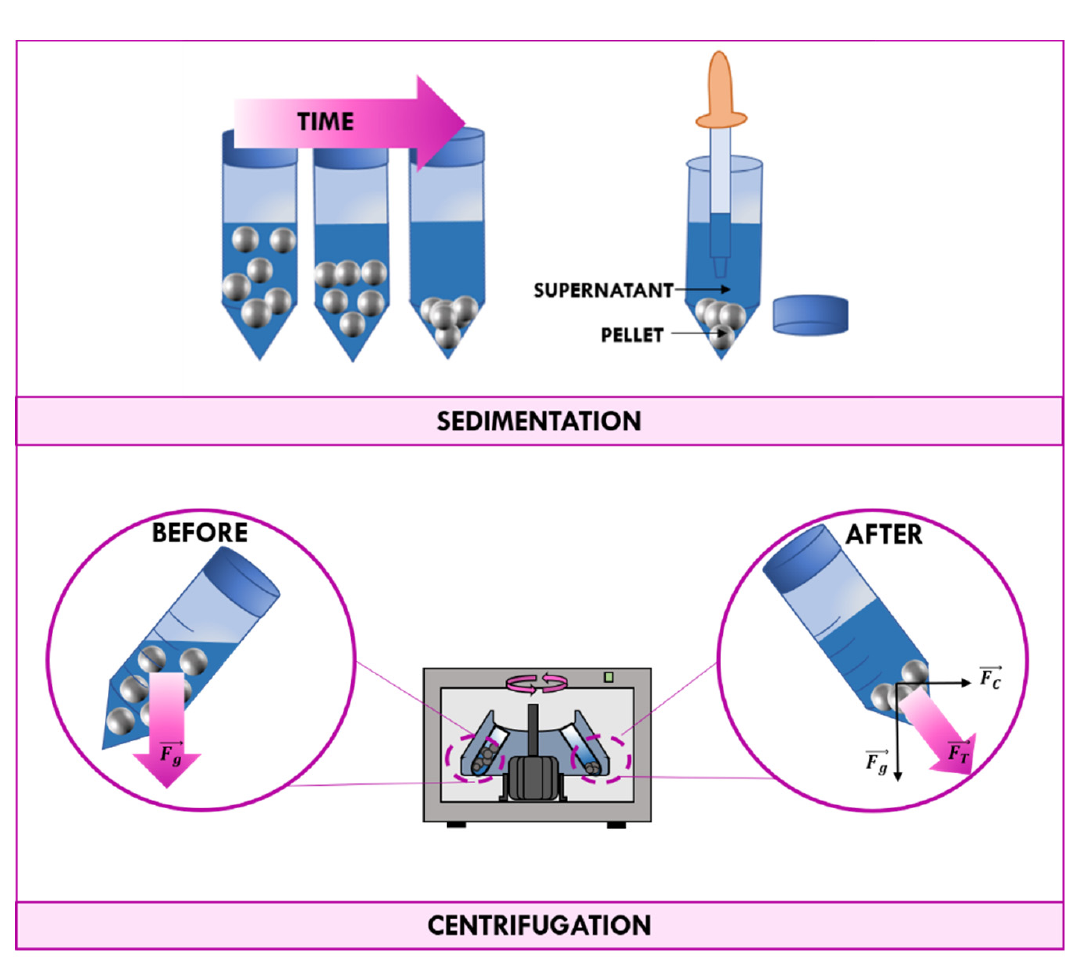
Figure 3. Schematic representation of the sedimentation and the centrifugation processes. According to Newton’s first law, a body tends to remain in a state on rest or linear uniform motion in the absence of forces acting upon it. When the body moves with uniform speed along a circular, a force directed towards the center of the circle acts upon it. This force is called centripetal force. Changing the frame of reference, the body moving in the curve path feels an apparent force called centrifugal force that has the same magnitude and dimensions as the centripetal force but points in the opposite direction. Such force is dependent on the speed of rotation in RPM and the distance of the body from the center of rotation. The centrifugal force provided by a centrifuge in combination with gravitational force cause particles to move radially away from the axis of rotation. More-dense particles of the mixture tend to move at the bottom of the tube, while less-dense particles of the mixture migrate towards the axis of the centrifuge. The solid deposited on the bottom of the tube is called “pellet”, while the remaining solution is called the “supernate” or “supernatant liquid”. The supernatant liquid can be quickly decanted from the tube without disturbing the precipitate, or aspirated with a Pasteur pipette